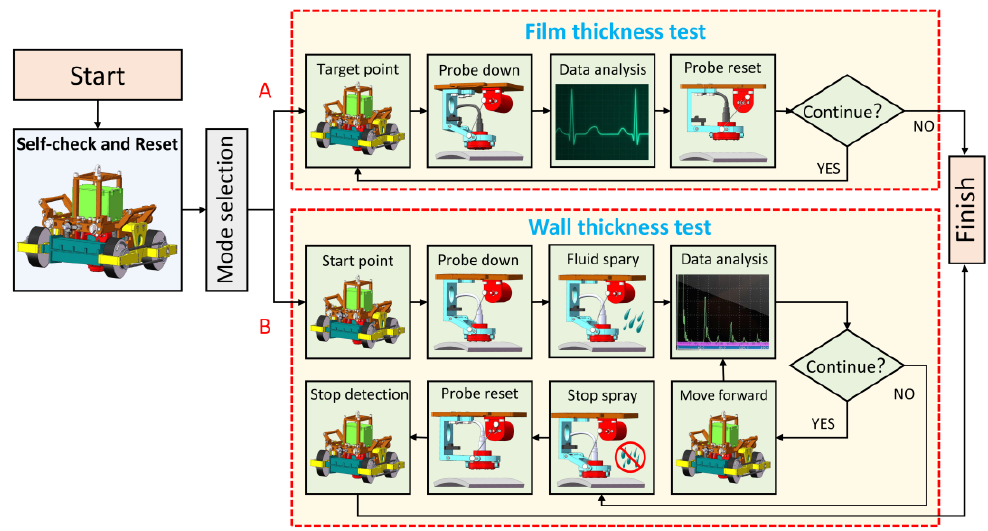
Figure 10. Robot detection workflow. ( A ) in the figure represents film thickness detection. ( B ) in the figure represents wall thickness detection.